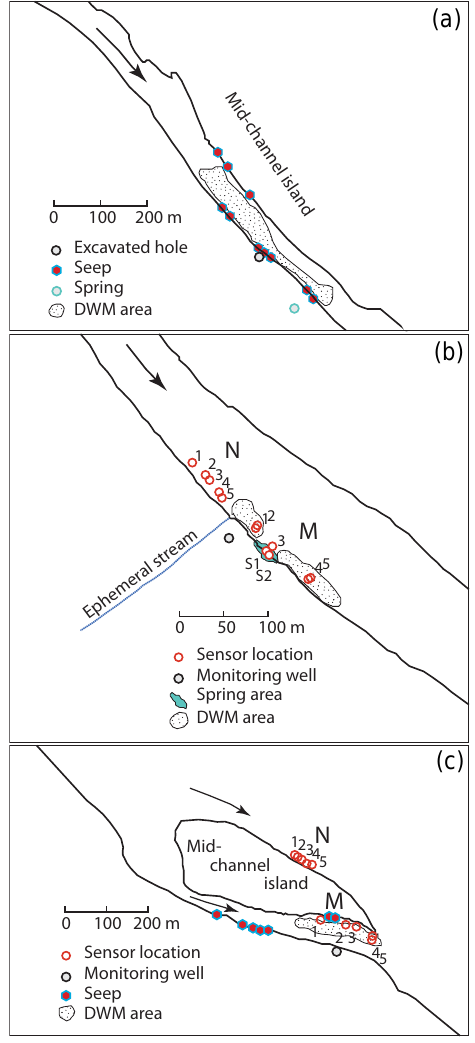
Figure 2. Sites 1 (a) , 2 (b) and 3 (c) . Arrows indicate direction of river flow. Sensor locations pertain to seepage-meter and in-river piezometer